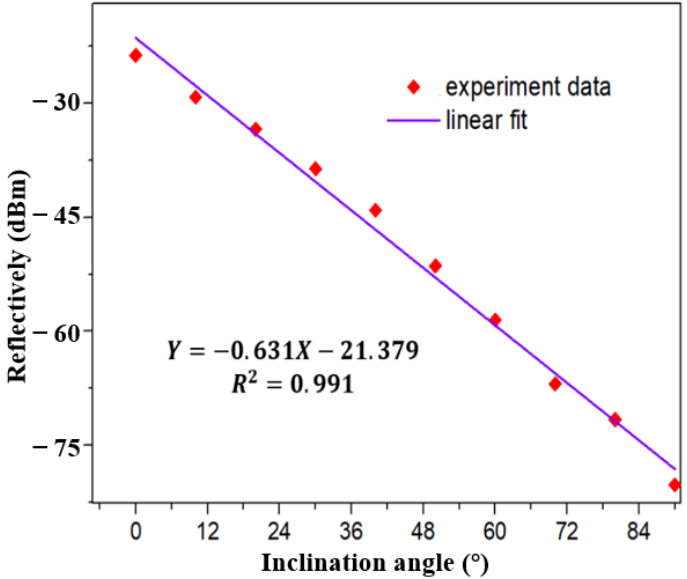
Figure 15. Linear fitting result of the relationship between reflectively and inclination angle in FRL system with step of 10 ◦ with waist equals 15 µ.